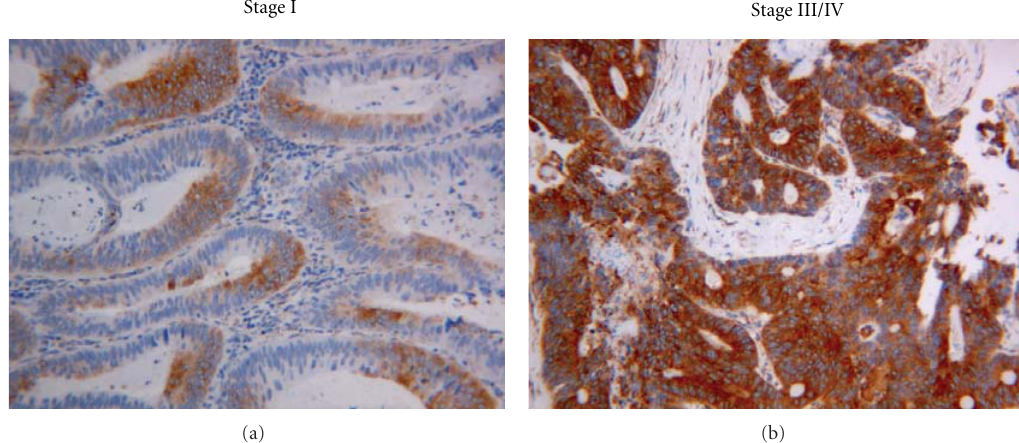
Figure 3: The di ff erence in Cx43 expression in stage I and stage III/IV colonic adenocarcinoma (original magnification × 200). A higher level of Cx43 expression was significantly associated with AJCC stage III/IV adenocarcinomas (Cx43 score 158 ± 10), as compared to AJCC stage I (Cx43 score 69 ± 12).